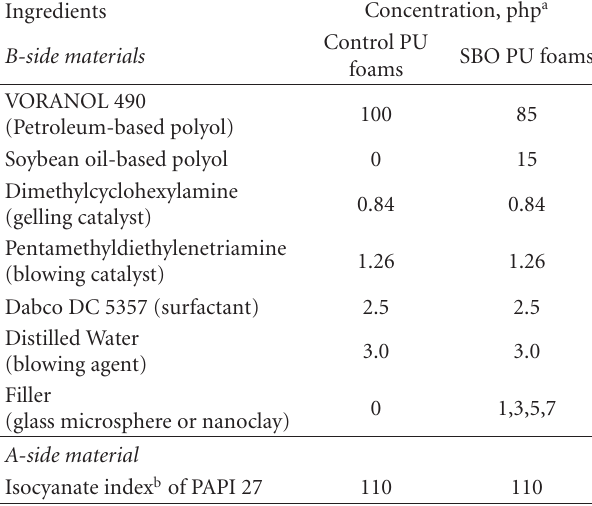
Figure 1: The e ff ect of microspheres and nanoclay on density of SBO